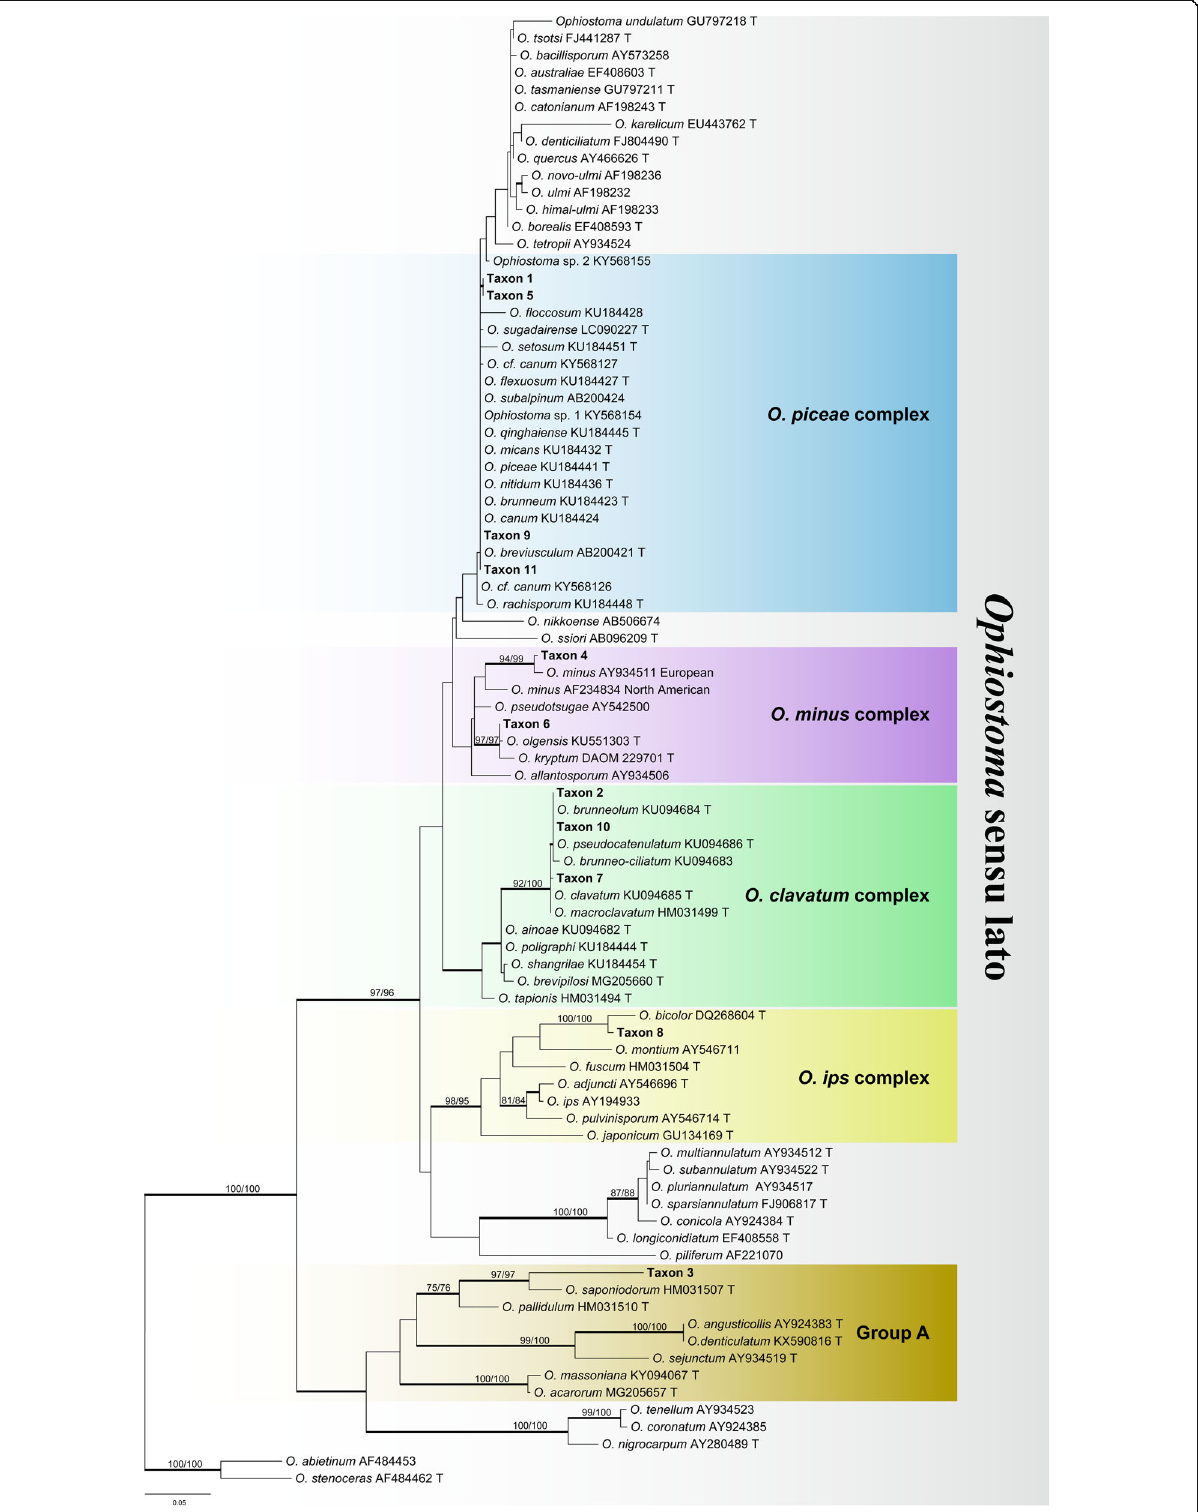
Fig. 2 ML tree of Ophiostoma generated from the ITS sequence data. Sequences generated from this study are printed in bold. Bold branches indicate posterior probability values ≥ 0.9. Bootstrap values of ML/MP ≥ 70% are recorded at the nodes. T = ex-type